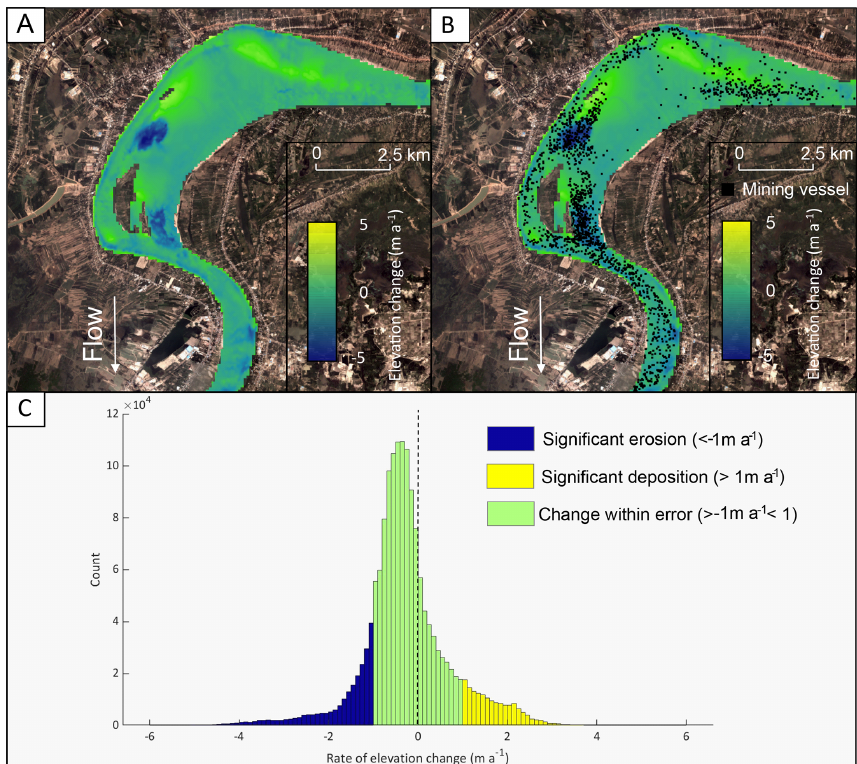
Figure 7. (a) Rate of elevation change between 2013 and 2019 of the Mekong River near Rokar Korng highlighting areas of erosion (blue) and deposition (yellow). (b) Overlain on the map depicted in (a) are the locations of all observed mining vessels during the period 2016 to 2020 demonstrating that the zones of greatest erosion observed in (a) correspond to areas of high mining activity. (c) Histogram of elevation changes for this reach between 2013 and 2019. The median rate of bed elevation change is − 0 . 25myr − 1 (mean elevation change is − 0 . 16myr − 1 ). The dashed line demarks zero net change in elevation. Image background in panels (a) and (b) are PlanetScope monthly composite scenes from December 2020 (Planet Team,